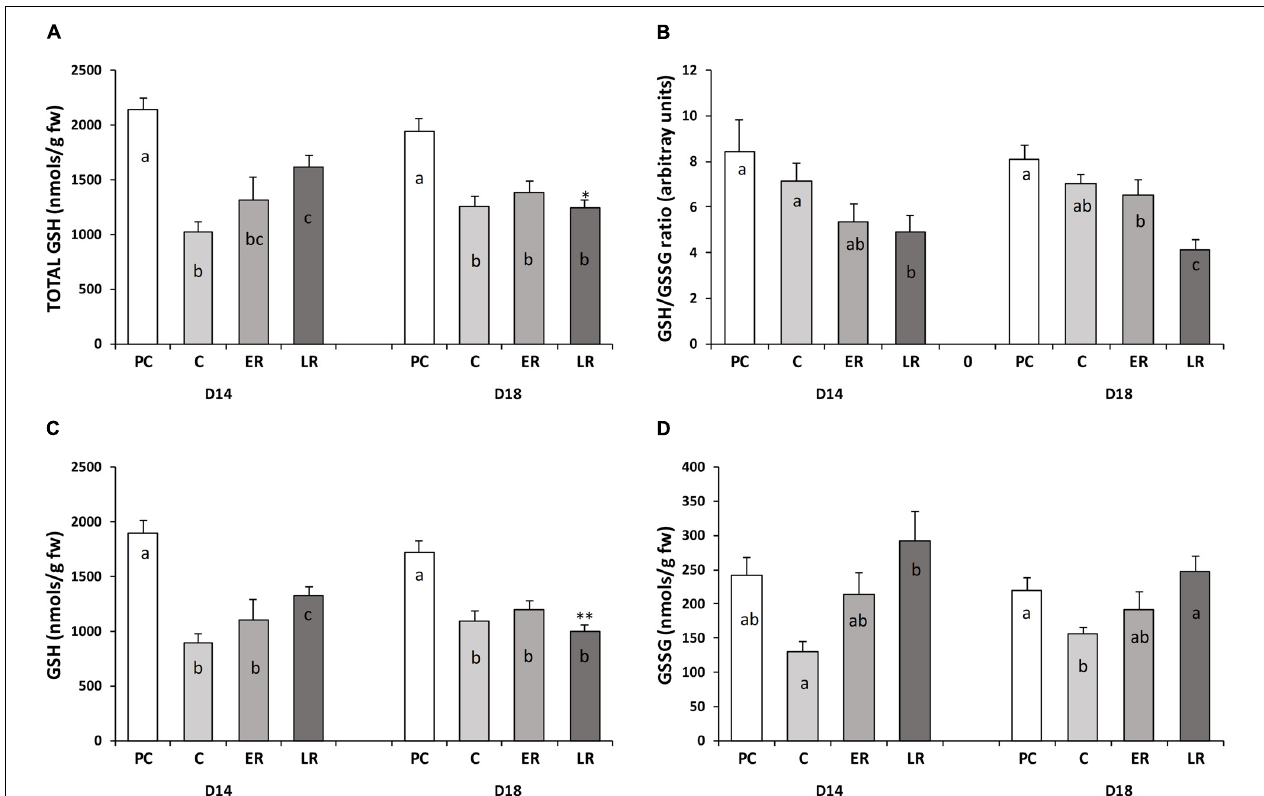
FIGURE 2 | Glutathione status in the liver of gilthead sea bream throughout the study period. (A) Total glutathione (tGSH), (B) the GSH/GSSG ratio, (C) the reduced form of glutathione (GSH), and (D) the oxidized form of glutathione (GSSG). Values are mean ± standard error of the mean. PRE-COLD, data obtained from day 30 of the pre-cold period at 22 ◦ C; COLD, data obtained after 50 days at 14 ◦ C (day 80); EARLY and LATE RECOVERY, data obtained 7 and 35 days after temperature restoration to 22 ◦ C (day 87 and 115), respectively. Lowercase letters (a–c) indicate significant differences between the periods within each diet ( p < 0.05, one-way ANOVA). Symbols ( ∗ ) indicate significant differences between diets at each period ( ∗ p < 0.05 vs. D14; ∗∗ p < 0.01 vs. D14; Student’s t